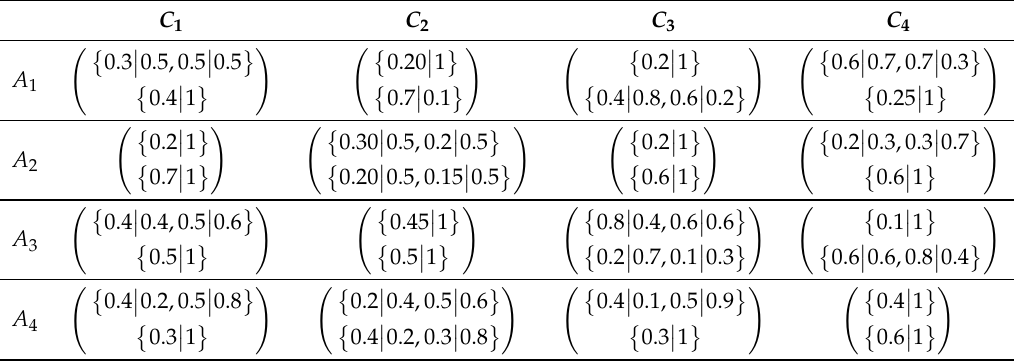
Table 2. Preference values provided by decision-maker 2.